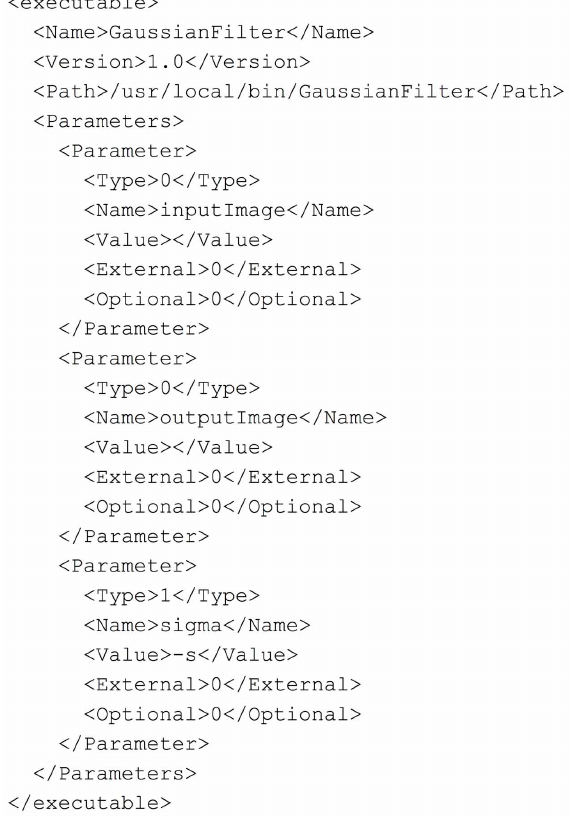
FIGURE 2 | GaussianFilter.bmm.